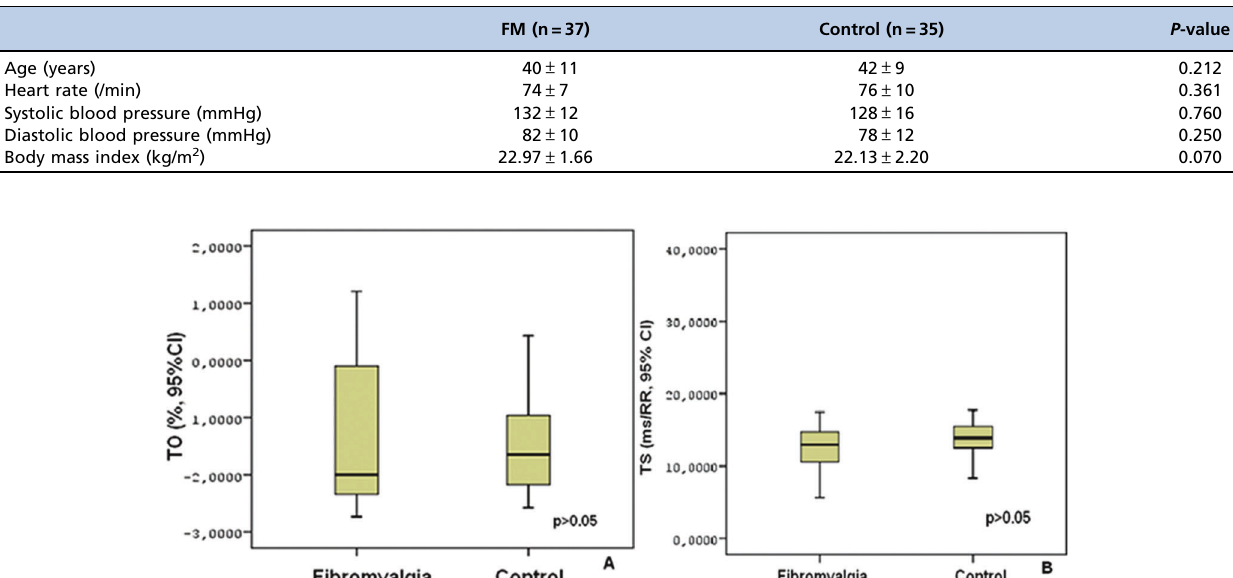
Table 1 - Clinical characteristics of the patient and control groups. Data are shown as n or the mean ± SD; FM-fibromyalgia.